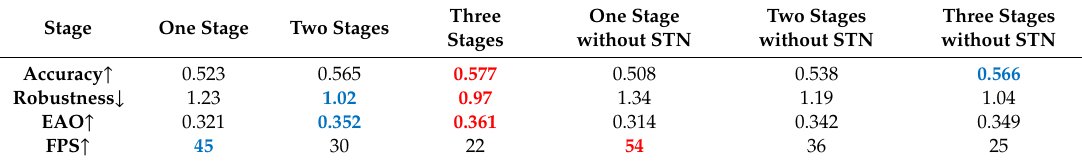
Table 1. The reliability ablation study on multi-features fusion considering the number of stages and STN. The best two results are highlighted in red and blue fonts,